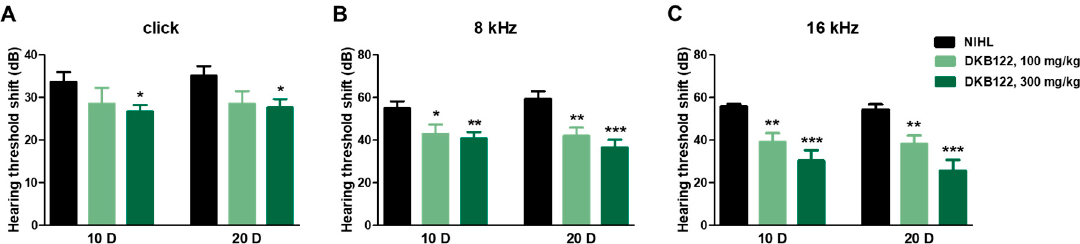
Figure 3. Effects of DKB122 on auditory function. Hearing thresholds shifts of Auditory Brainstem